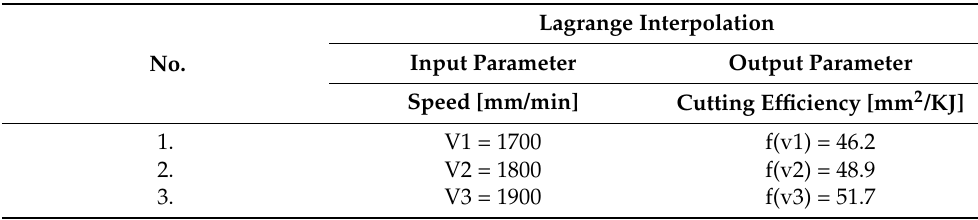
Table 7. Experimental data used in the Lagrange interpolation